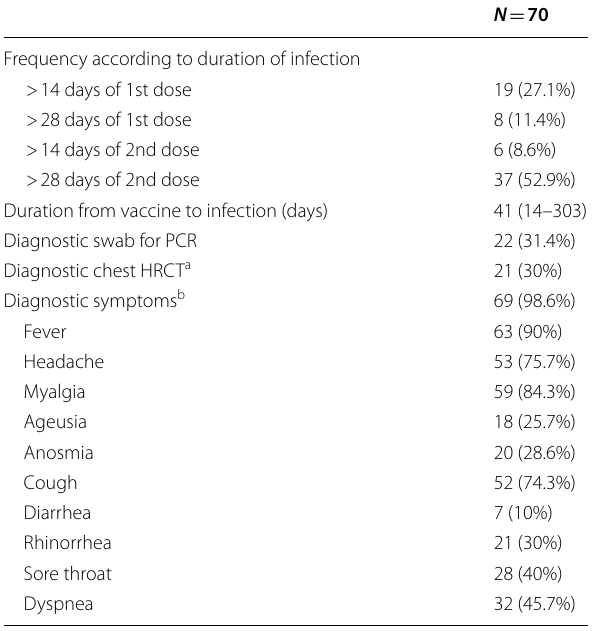
Table 5 Site of care for patients developed post-vaccine COVID- 19 infection group B ( N